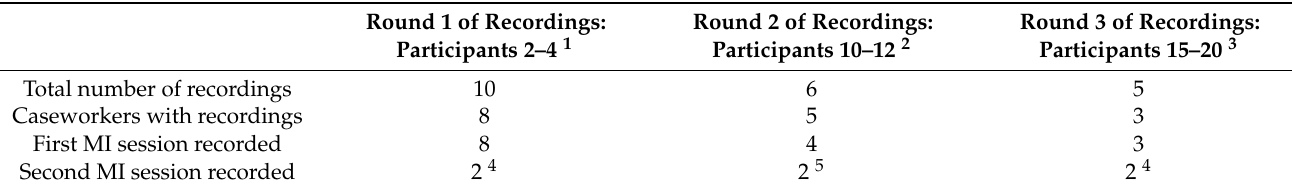
Table 1. Overview of total number of audio recordings, rounds of recording and type of motivational interviewing (MI)